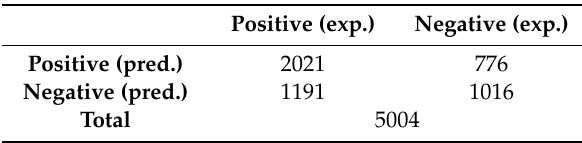
Table 4. True positives (TPs), true negatives (TNs), false positives (FPs) and false negatives (FNs) in top-1 predictions a by the Transformer-transfer-learning model.